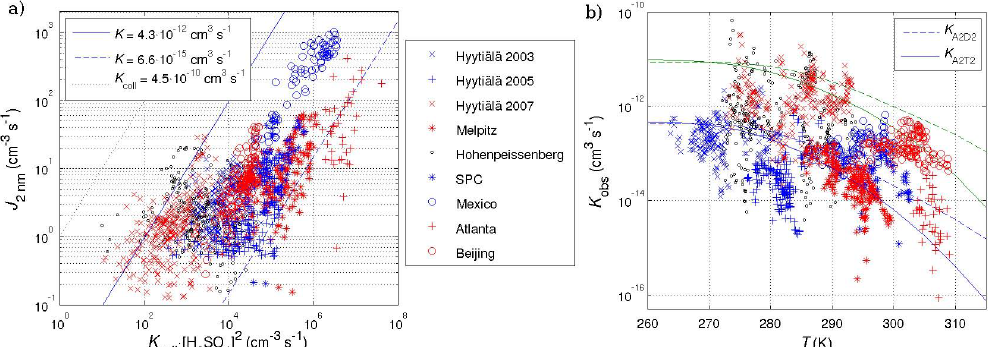
Fig. 8. (a) The measured formation rate of 2nm particles ( J 2nm ) as a function of sulphuric acid monomer collision rate. The solid and dashed lines correspond to the 95th and 5th percentile of the data point specific values of J /( K coll · [H 2 SO 4 ] 2 ) , respectively, leaving 90% of the data points between the lines. The collision rate between sulphuric acid monomers is depicted with a dotted line. Panel (b) shows the observed coefficient K obs as a function of temperature. The solid and dashed lines correspond to the values of the modelled coefficients K A2D2 and K A2T2 , respectively, at amine concentrations of 10 5 cm − 3 (blue lines) and 10 6 cm − 3 (green lines), RH = 50% and [A 1 , tot ] = 10 7 cm − 3